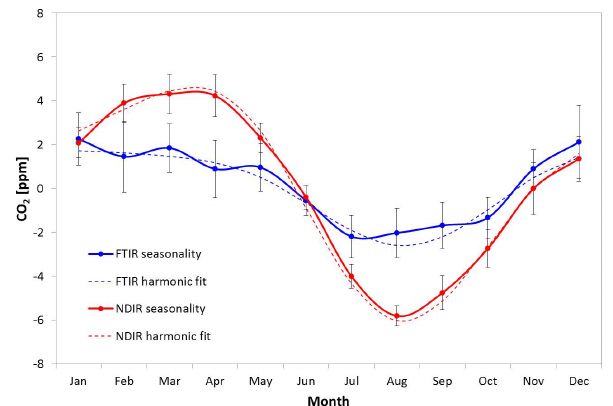
Figure 5. Monthly averaged seasonality of the filtered FTIR and NDIR CO 2 measurements for the 9 years of the comparison: aver- aged NDIR seasonality (red), two harmonic fit of the NDIR season- ality (red dashed line), averaged FTIR seasonality (blue), and two harmonic fit of the FTIR seasonality (dashed blue